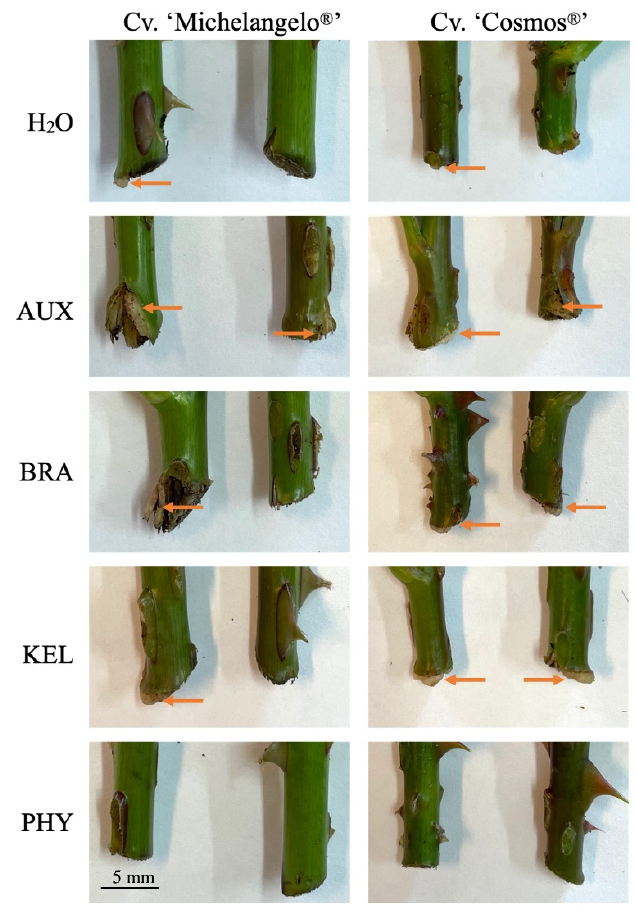
Figure 2. Images of cuttings 16 days after the start of treatments. Orange arrows indicate the callus